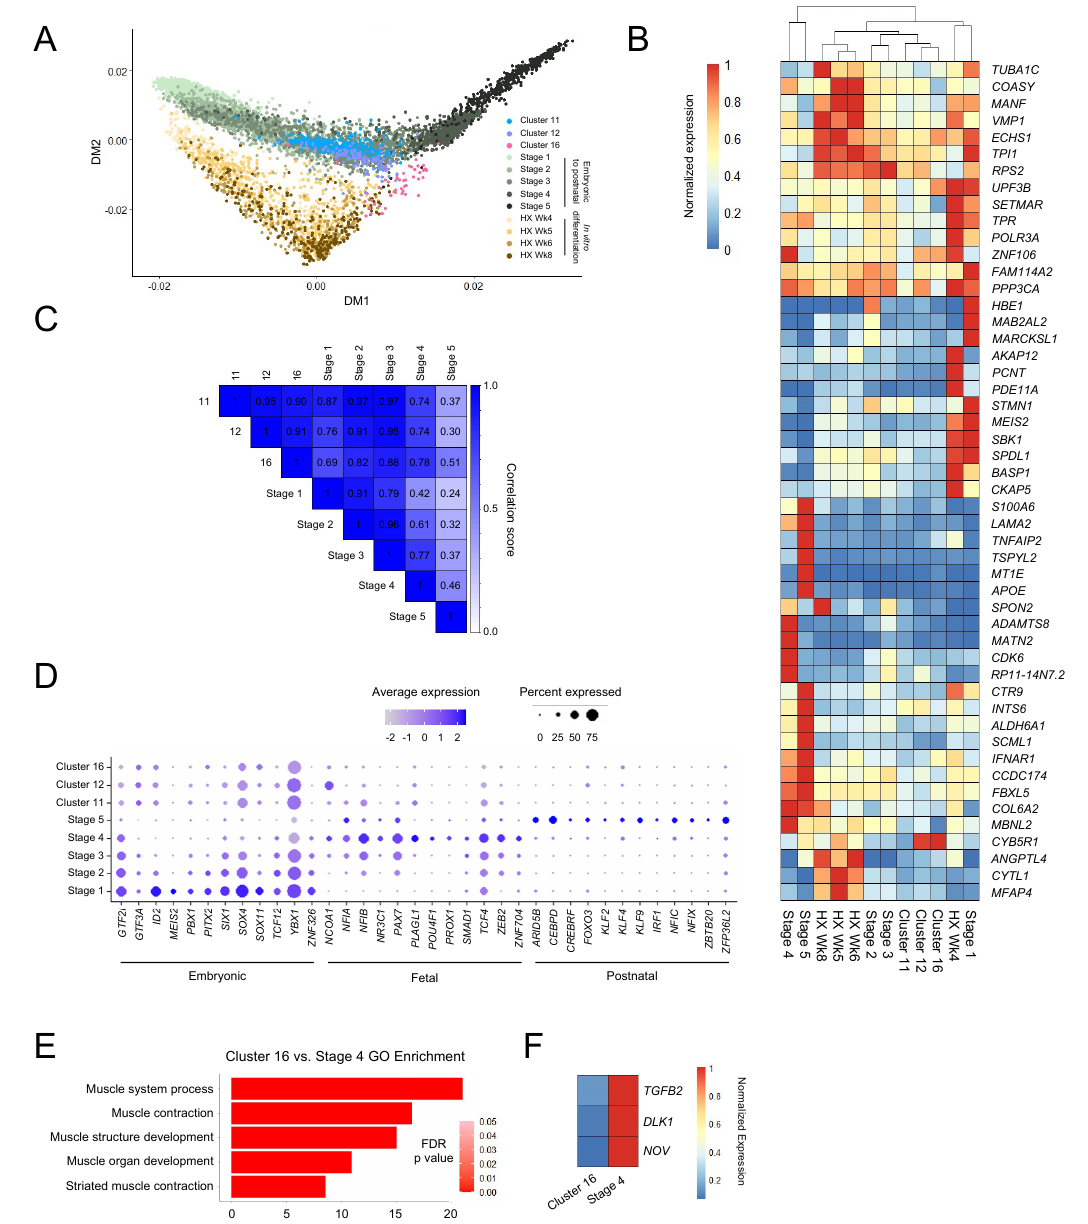
Figure 3. Skeletal myogenesis in teratomas recapitulates muscle development in vivo. ( A ) Diffusion map of teratoma-derived skeletal myogenic progenitors from the current study (Clusters 11, 12, and 16), and human muscle tissues (Stage 1–5) and in vitro differentiated cells (HX Wk4–8) from Xi et al. [40]. Human samples were collected from embryonic week 5 limb muscles to adult muscle biopsies, and in vitro cells were collected at 4–8 weeks of skeletal myogenic differentiation [40]. ( B ) Heatmap showing normalized expression of the top 50 differentially expressed genes among the skeletal myogenic populations. ( C ) Transcriptome correlation analysis of teratoma-derived and human skeletal myogenic cells. ( D ) Dot plot showing expression profiles of various transcription factors across embryonic, fetal, and postnatal stages for the skeletal myogenic populations. ( E ) Top five GO terms of differentially expressed genes that distinguish Cluster 16 cells from Stage 4 cells. ( F ) Differentially expressed genes in the TGF β ( TGFB2) and Notch ( DLK1, NOV ) signaling pathways between Cluster 16 cells and Stage 4